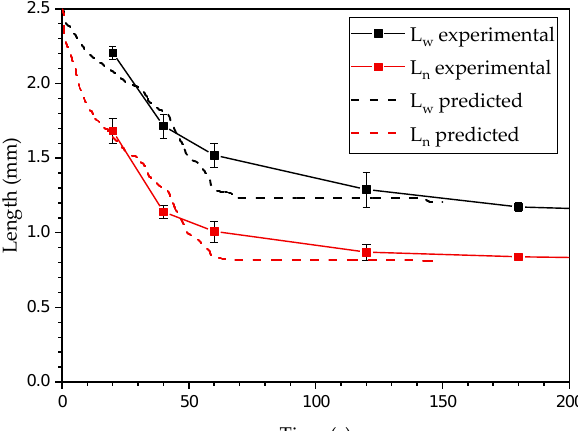
Figure 14. Fiber length evolution compared to the Couette flow experiment with fiber relaxation and probability breakage applied in simulation.